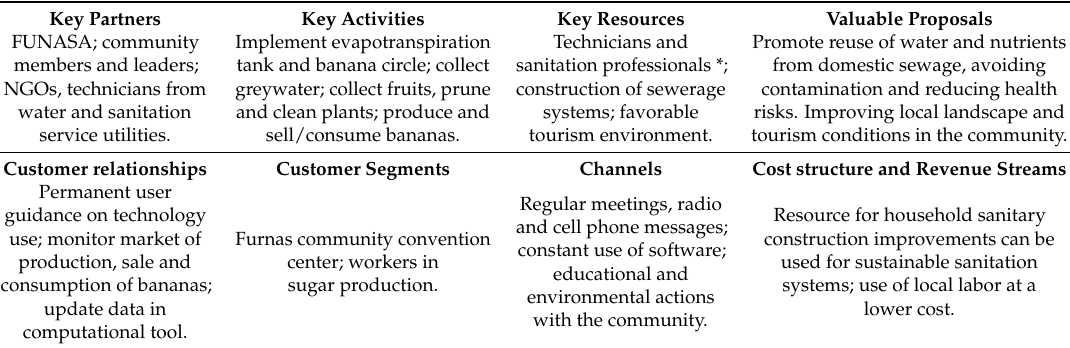
Table 3. Schematic business Canvas business model